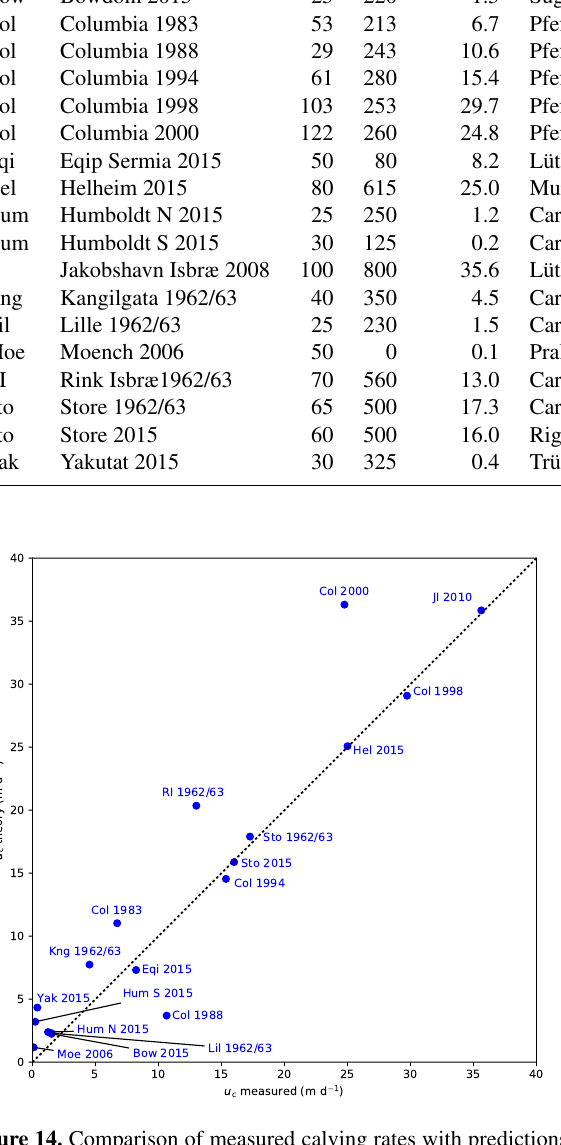
Figure 14. Comparison of measured calving rates with predictions from the calving parametrization. The glacier names are abbreviated according to Table